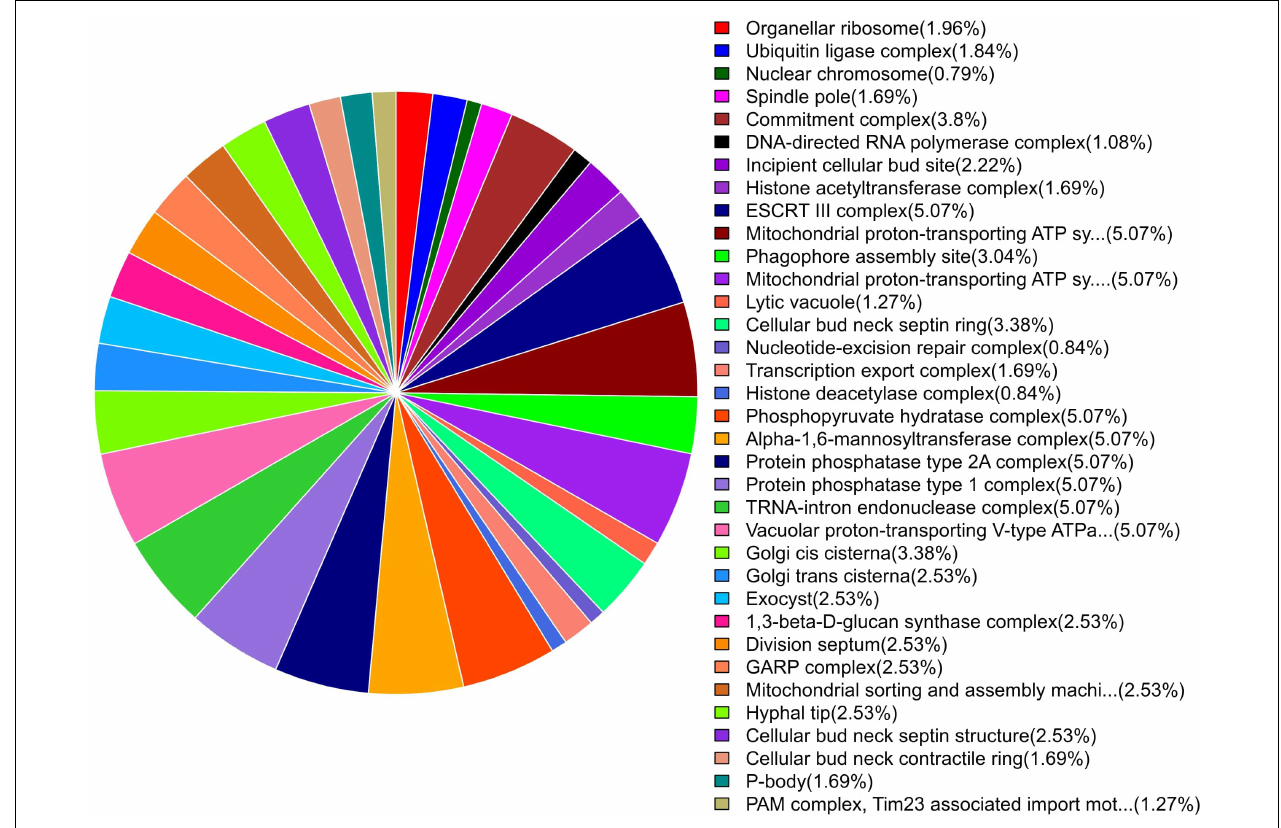
FIGURE 5 | Pie chart of enriched GO terms of B. maydis for cellular functions differentially expressed in inoculated resistant and susceptible